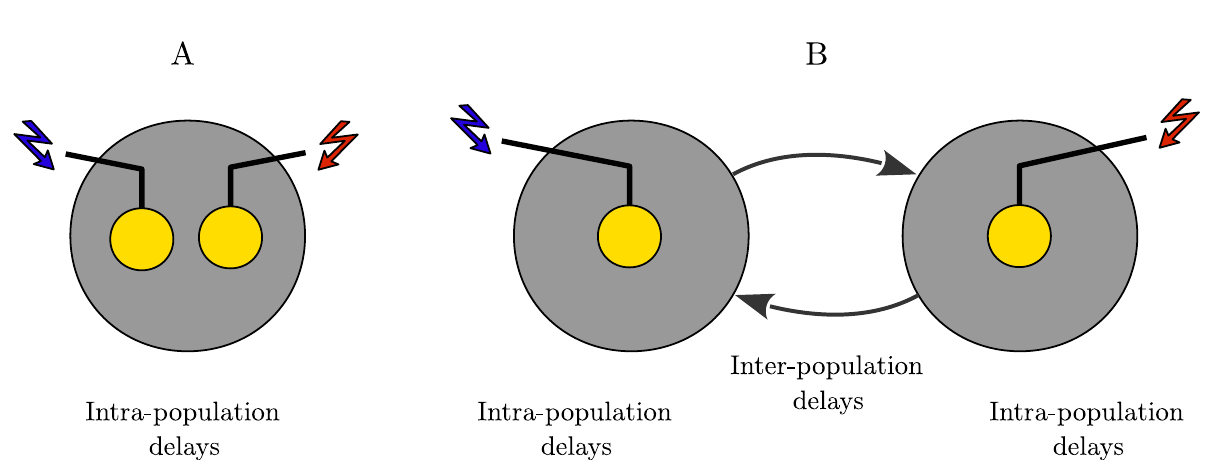
Fig 9. Illustrative representation of the time-shifted stimulation. ( A ) Schematically refers to a variety of bi-/multichannel stimulation techniques where the delays between different stimulation sites (yellow circles) are approximately the same. ( B ) Schematically refers to bi-/multichannel stimulation techniques with at least two qualitatively different delays, i.e., small delays within and long delays between stimulation sites.